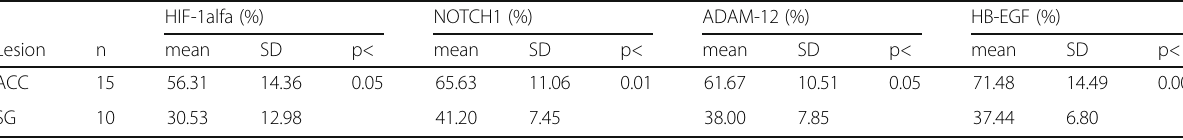
Table 2 The p values when comparing HIF-1 α , NOTCH1, ADAM-12, and HB-EGF expression among ACC and SG, Kruskal – Wallis